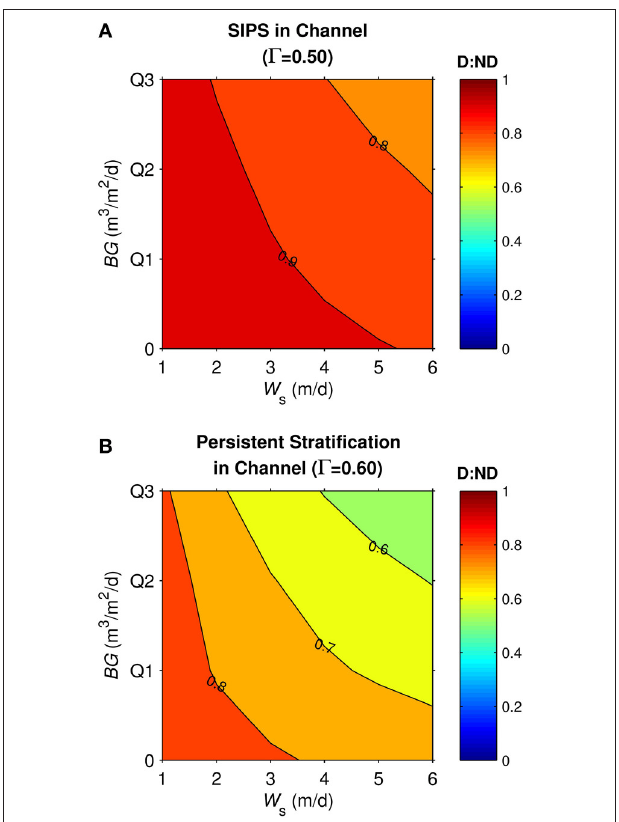
FIGURE 11 | Diatom:non-diatom ratios (D:ND) for coupled shoal-channel system representative of Suisun Bay. D:ND is based on computed diatom and non-diatom biomass at 7 simulation days volume-integrated across the shoal-channel complex, and is shown for multiple combinations of benthic grazing rate ( BG ) and diatom sinking speed ( W s ). (A) Suisun Bay SIPS hydrodynamic case in the channel ( Γ = 0.50km − 1 ), (B) Suisun Bay persistent neap-tide stratification in the channel ( Γ = 0.60km − 1 ). “Q1,” “Q2,” and “Q3” refer to the historical first-third